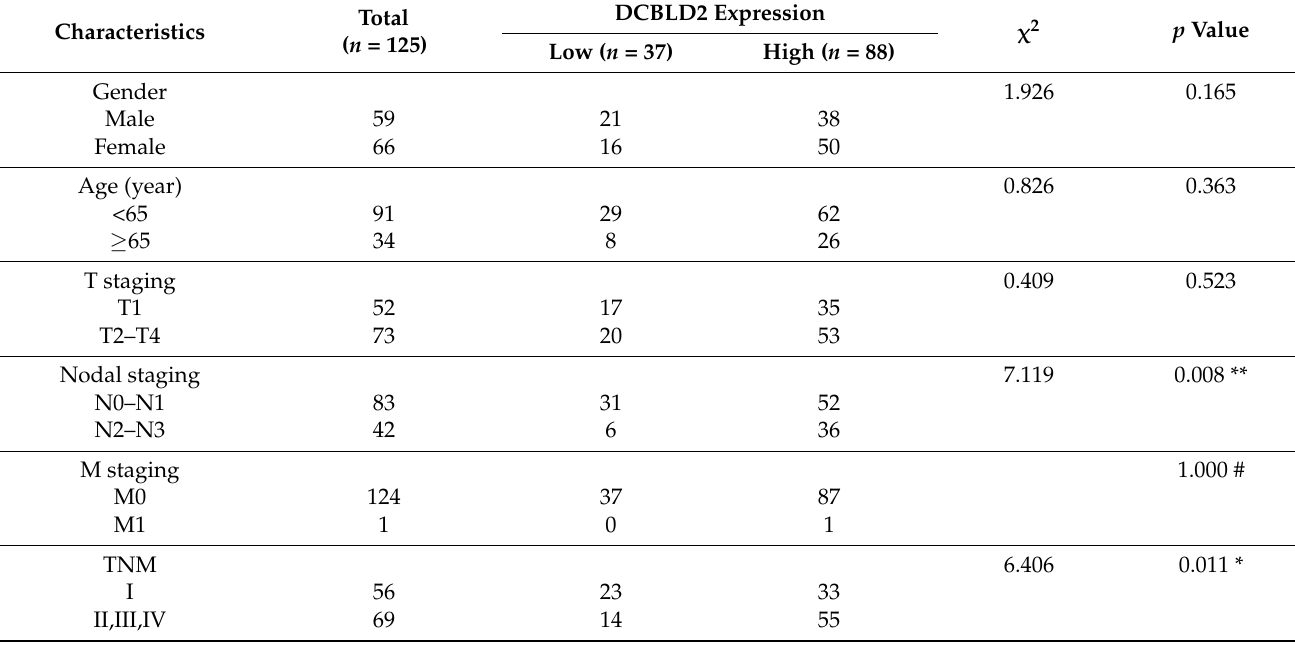
Table 2. Association between DCBLD2 expression and clinicopathological features of patients with LUAD from Tianjin Medical University Cancer Institute and Hospital. Cut off: H score = 5, * p < 0.05, ** p < 0.01, Chi-square test, except for #: Fisher